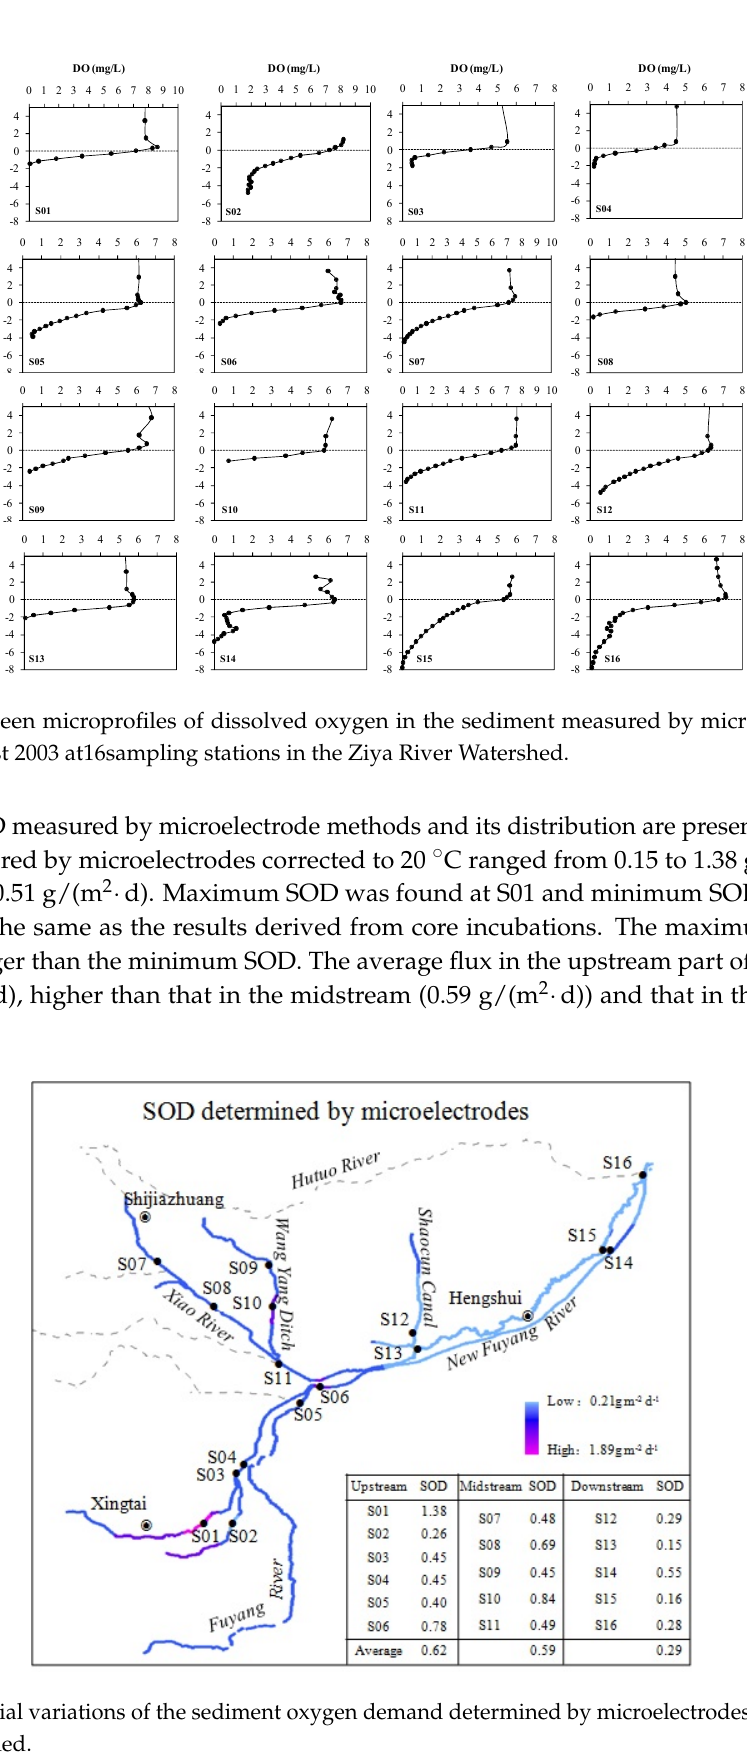
Figure 5. Spatial variations of the sediment oxygen demand determined by microelectrodes in the Ziya River